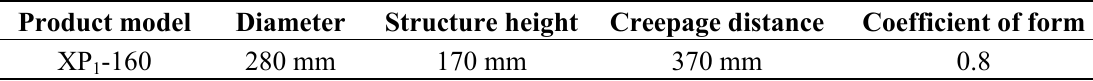
Table 4. Parameters of test samples